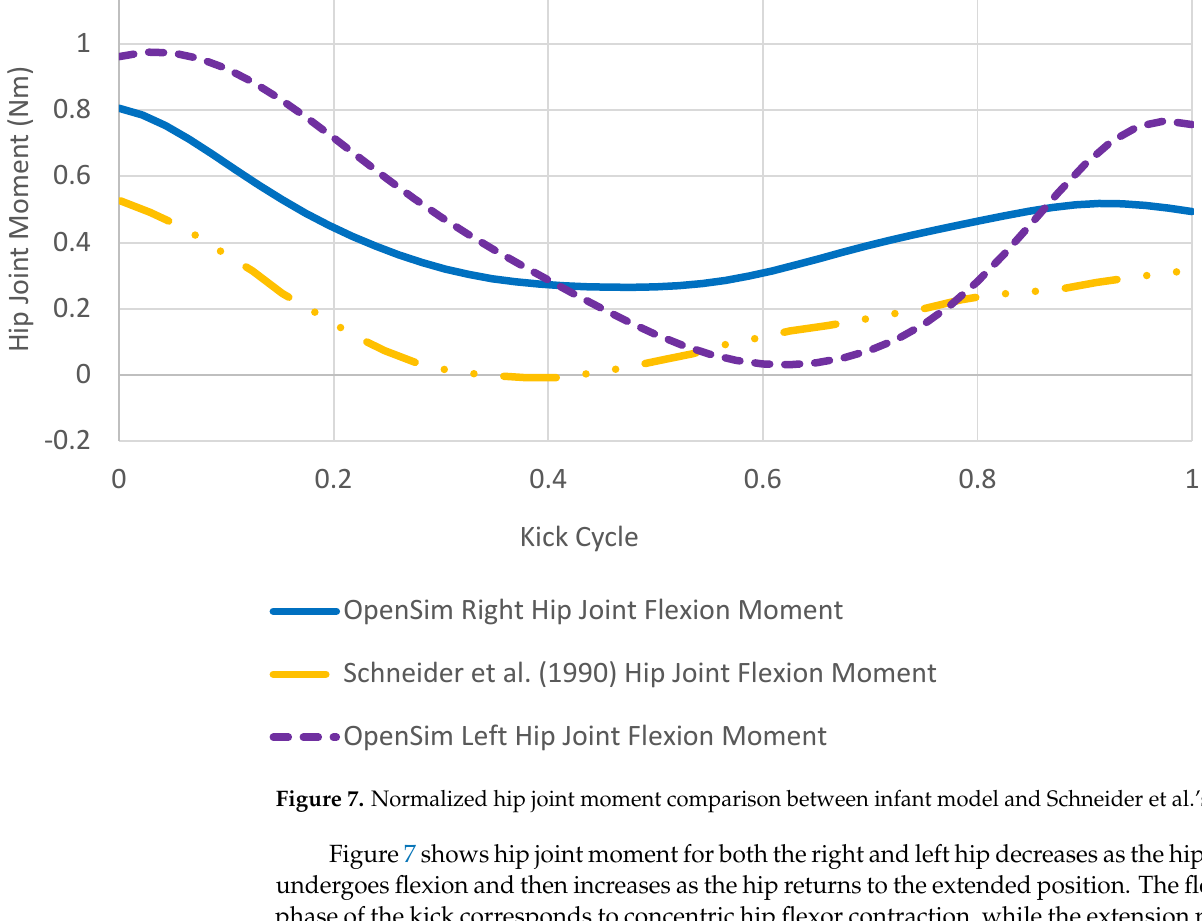
Figure 7. Normalized hip joint moment comparison between infant model and Schneider et al.’s [33]. Figure 7 shows hip joint moment for both the right and left hip decreases as the hip joint undergoes flexion and then increases as the hip returns to the extended position. The flexion phase of the kick corresponds to concentric hip flexor contraction, while the extension phase corresponds to eccentric hip flexor contraction. This trend coincides with the results found in Schneider et al.’s study in their joint moment calculations [33]. Similar to the comparison made on the hip joint angle, a trend agreement was observed when comparing moment values from the infant model to reported values from the literature [33]. There was a hip joint moment difference of 0.275 Nm (right hip) and 0.083 Nm (left hip) when compared to the literature. This maximum difference (right: 0.283 Nm; left: 0.039 Nm) was observed at the corresponding time of maximum hip flexion angle. The difference in moments can